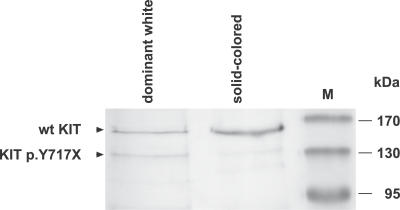
Western Blot Analysis of KIT Protein Expression in Skin SamplesA strong band of the expected size of glycosylated wild-type KIT protein was detected in the protein sample from the solid-colored horse. Protein extract from the skin of a dominant white horse yielded two very weak bands. The sizes of the two bands corresponded to wild-type and truncated KIT protein, respectively. As the skin sample from the dominant white horse did not contain melanocytes, the weak bands presumably were due to other KIT-expressing cells that may have been present in the skin biopsy.